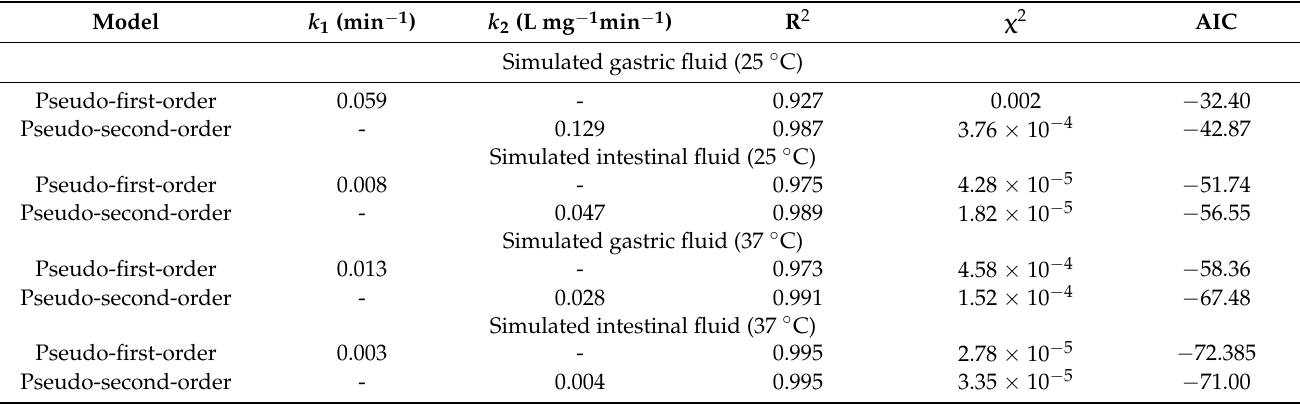
Figure 10. Results of the pseudo-first- and pseudo-second-order kinetic models during the controlled MB release from the chitosan/DNA blend hydrogel in simulated gastric fluid at 25 ◦ C ( a ) and 37 ◦ C ( c ), and simulated intestinal fluid at 25 ◦ C ( b ) and 37 ◦ C ( d ). Experimental conditions: dried hydrogel mass of 10.0 mg and constant stirring of 110 rpm. Table 5. Fitting parameters of the pseudo-first- and pseudo-second-order kinetic models for the release of MB from the chitosan/DNA blend hydrogel in different